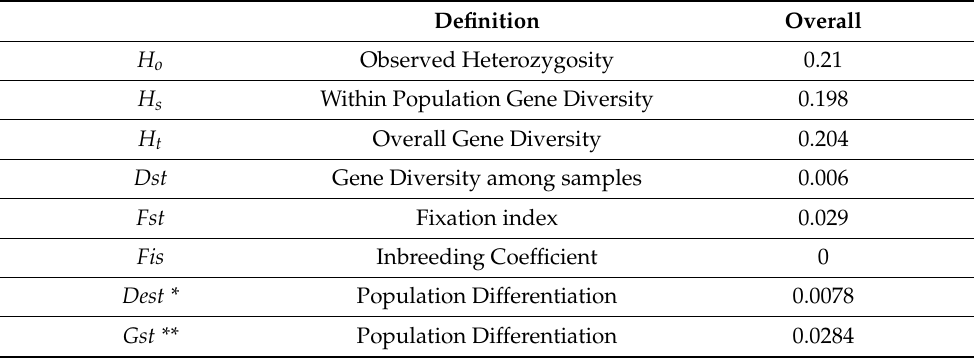
Table 1. Summary of the genetic diversity and differentiation of the IUFRO population. Definition Overall H o Observed Heterozygosity 0.21 H s Within Population Gene Diversity 0.198 H t Overall Gene Diversity 0.204 Dst Gene Diversity among samples 0.006 Fst Fixation index 0.029 Fis Inbreeding Coefficient 0 Dest * Population Differentiation 0.0078 Gst ** Population Differentiation